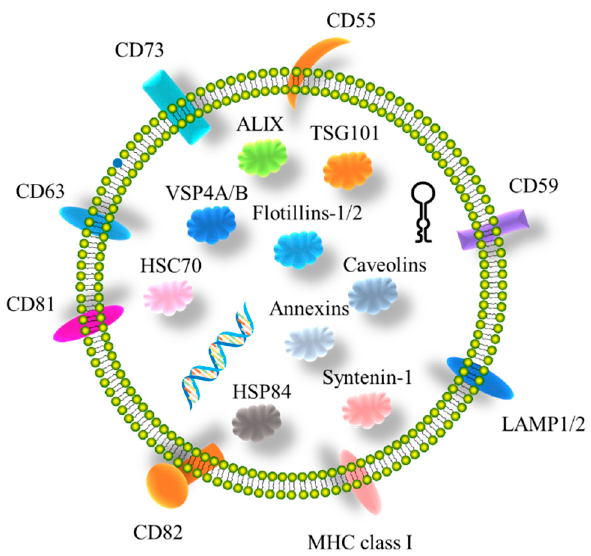
Figure 1. Biomarkers of sEVs. Transmembrane/lipid-bound proteins: CD55, CD59, CD63, CD73, CD81, CD82, LAMP1/2, and MHC class I; Cytosolic proteins: ALIX, Annexins, Caveolins, Flotillins- 1/2, HSC70, HSP84, Syntenin-1, TSG101, and VSP4A/B.